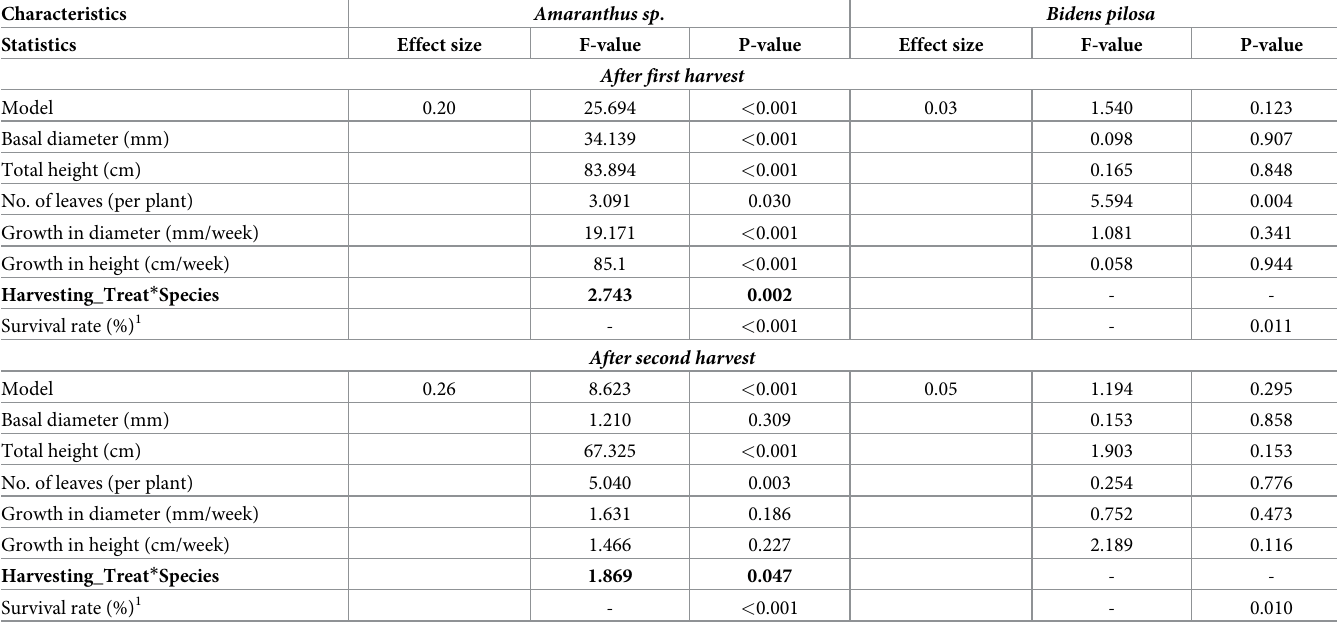
Table 4. Results of the Multivariate Analysis of Variance and log-linear analysis for the impact of leaf harvesting on the study species.